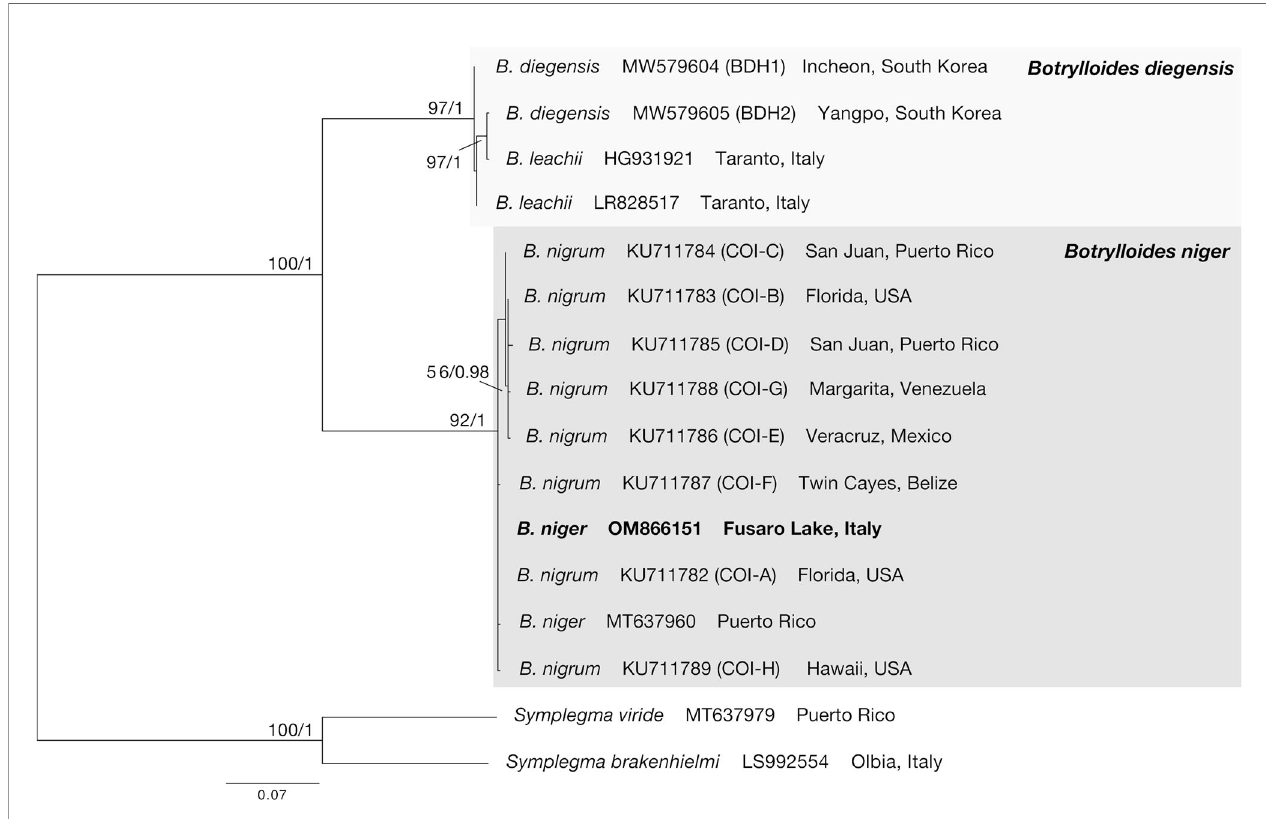
FIGURE 2 | COI phylogenetic tree obtained from the alignment of 16 terminals. Numbers above/below branches represent bootstrap values (bs) and bayesian posterior probabilities (pp). Specimens sequenced in this study highlighted in